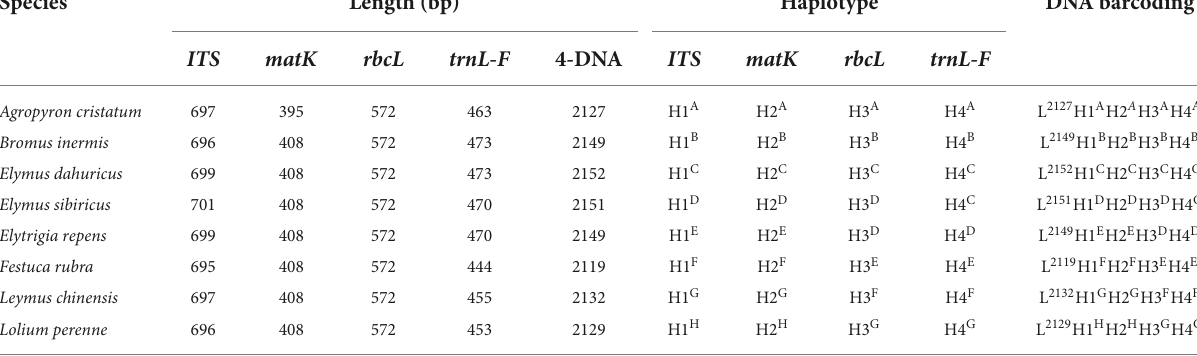
TABLE 3 Database of DNA barcoding for eight species grasses.